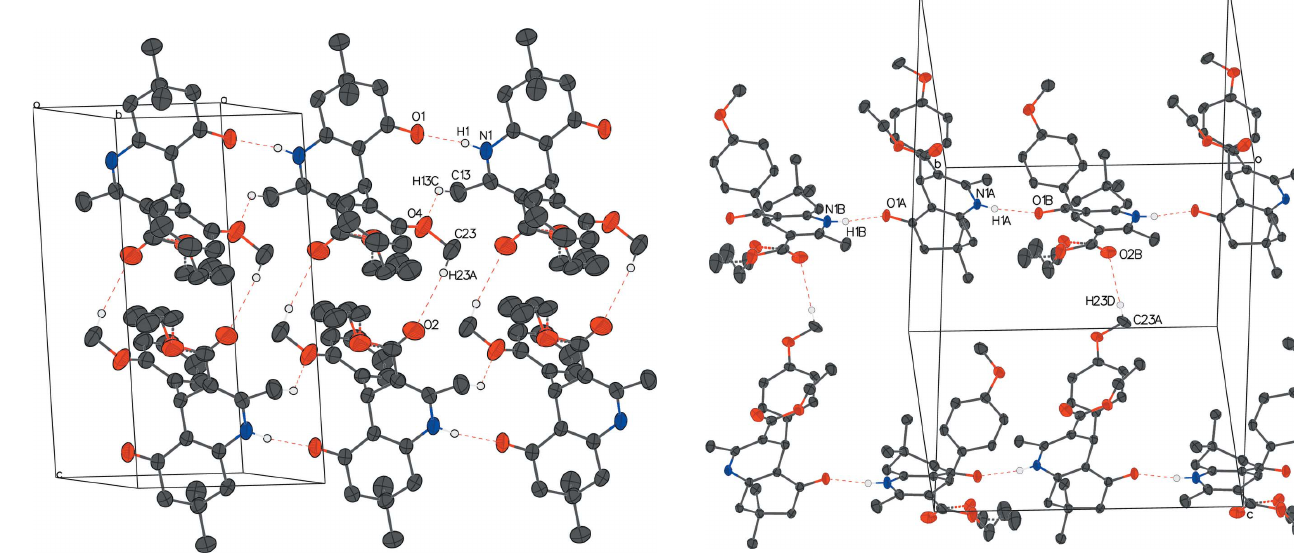
Figure 5 The packing of title compound II . H atoms bonds are shown as dashed lines. H atoms not involved in these hydrogen bonds are removed for